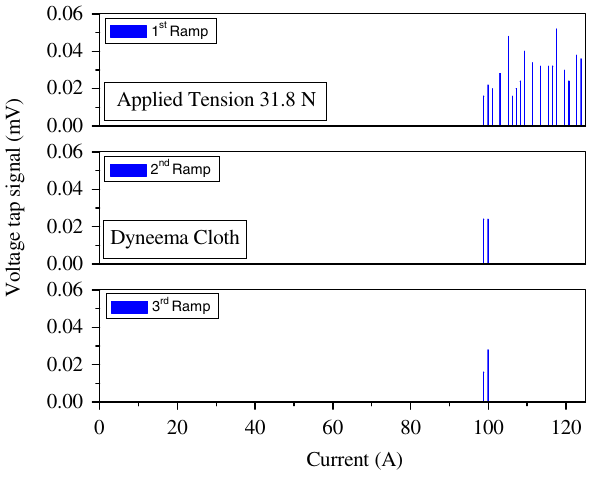
FIG. 7. (Color) Dependence of current at which wire motion starts with